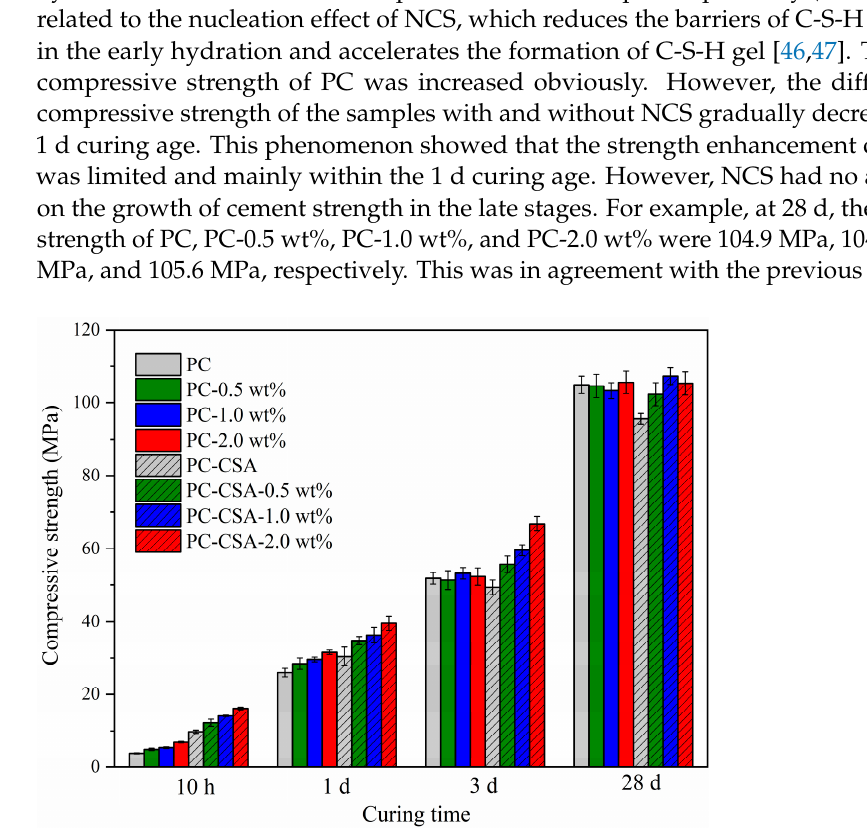
Figure 3. Compressive strength of different binders. Table 6. The compressive strength growth ratio of PC with the addition of CSA or/and NCS.